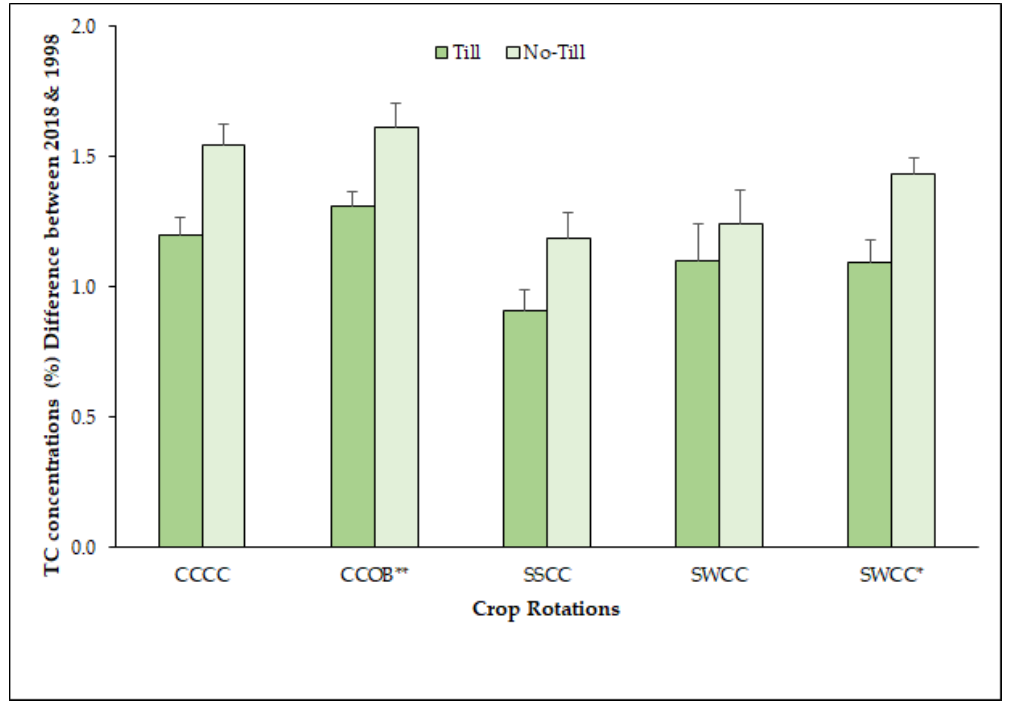
Figure 4. The estimated change in topsoil total carbon (TC) content in five crop rotations for both tilled and no-tilled plots for 1998 to 2018 period. The 1998 TC data are available only for the displayed five plotted combinations of rotations. Error bars indicate SE of the mean. Asterisks refer to red clover undersown to cereals. Table 3. Shows TC content changes over time between 2009 and 2018. Overall, the same increasing TC trend was also recorded in a dataset collected in 2009 over corn/till interaction plots. The highest changes were from about 21% for CCAA followed by CCSW* with red clover (19%) and CCCC (18%), whereas the lowest changes were for CCSS and CCSW with 10% and 12%. respectively.